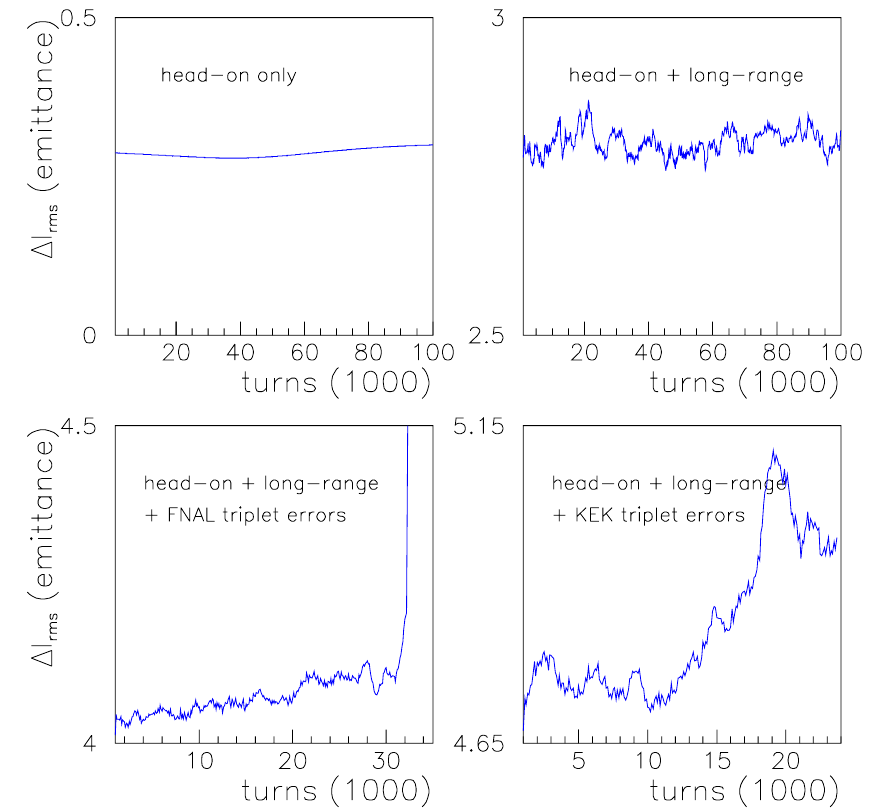
FIG. 7. (Color) The variance in action (in units of rms emittance) for a group of 100 particles as a function of turn number. The particles were launched with identical transverse action corresponding to 6 s x , y in both transverse planes and with random betatron phase. The figure demonstrates the effects of head-on collisions, long-range interactions, and triplet nonlinearities,